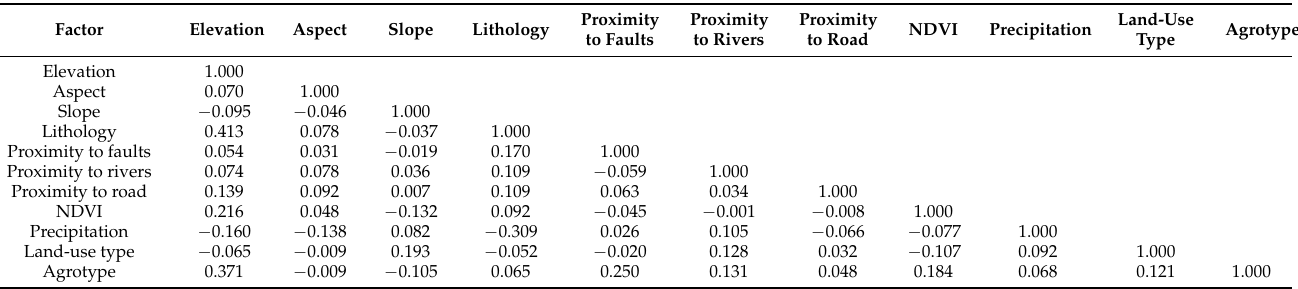
Table 2. Correlation values of each